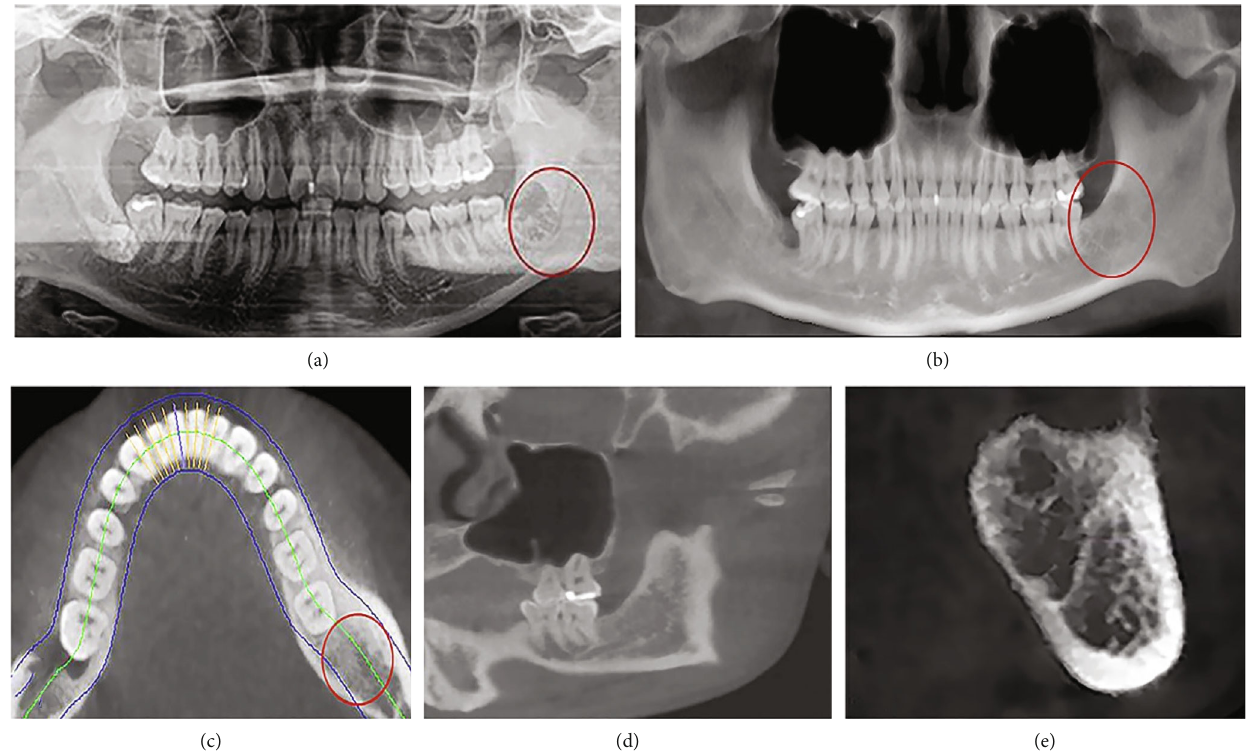
Figure 4: (a) Immediate postoperative panoramic examination showed the empty tooth socket; (b) after six months, CBCT examination showed good bone formation, and the alveolar bone healed well. (c) Transverse section shows increased bone density in empty alveolar bone; (d, e) Coronal and sagittal plane shows increased height of the alveolar